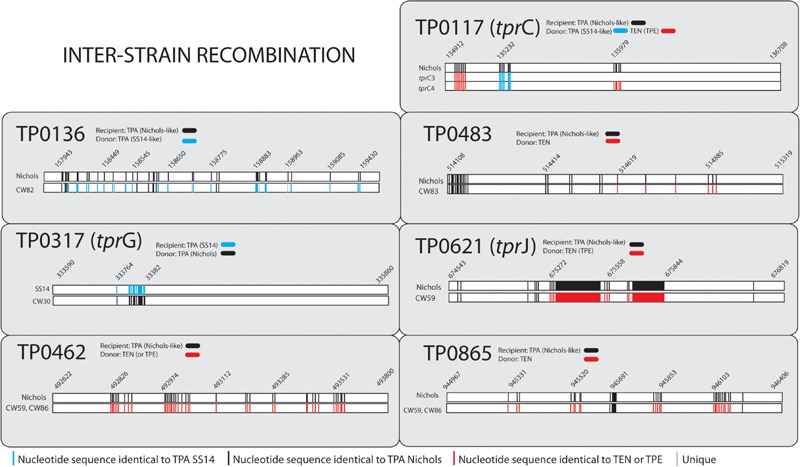
Inter-clade recombination events found among examined clinical samples. Coordinates according to the reference Nichols (CP04010.1) and reference SS14 (CP004011.2) for the Nichols-like and SS14-like clinical samples, respectively. Only positions with nucleotide differences are shown. The detailed description of the Figure 3 is given in the Supplementary Text S2.